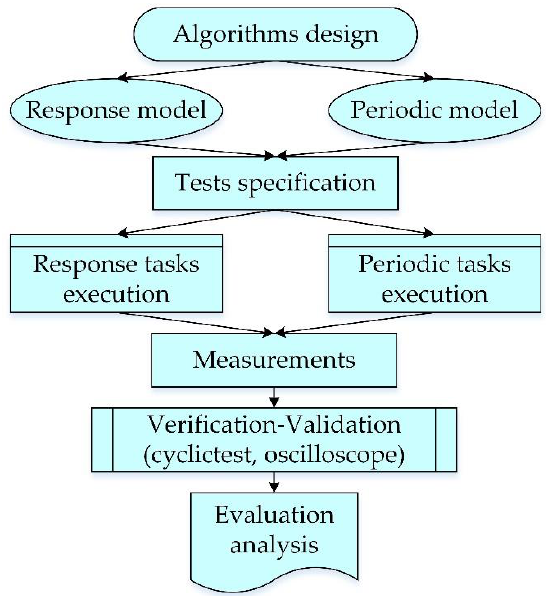
Figure 1. Research process